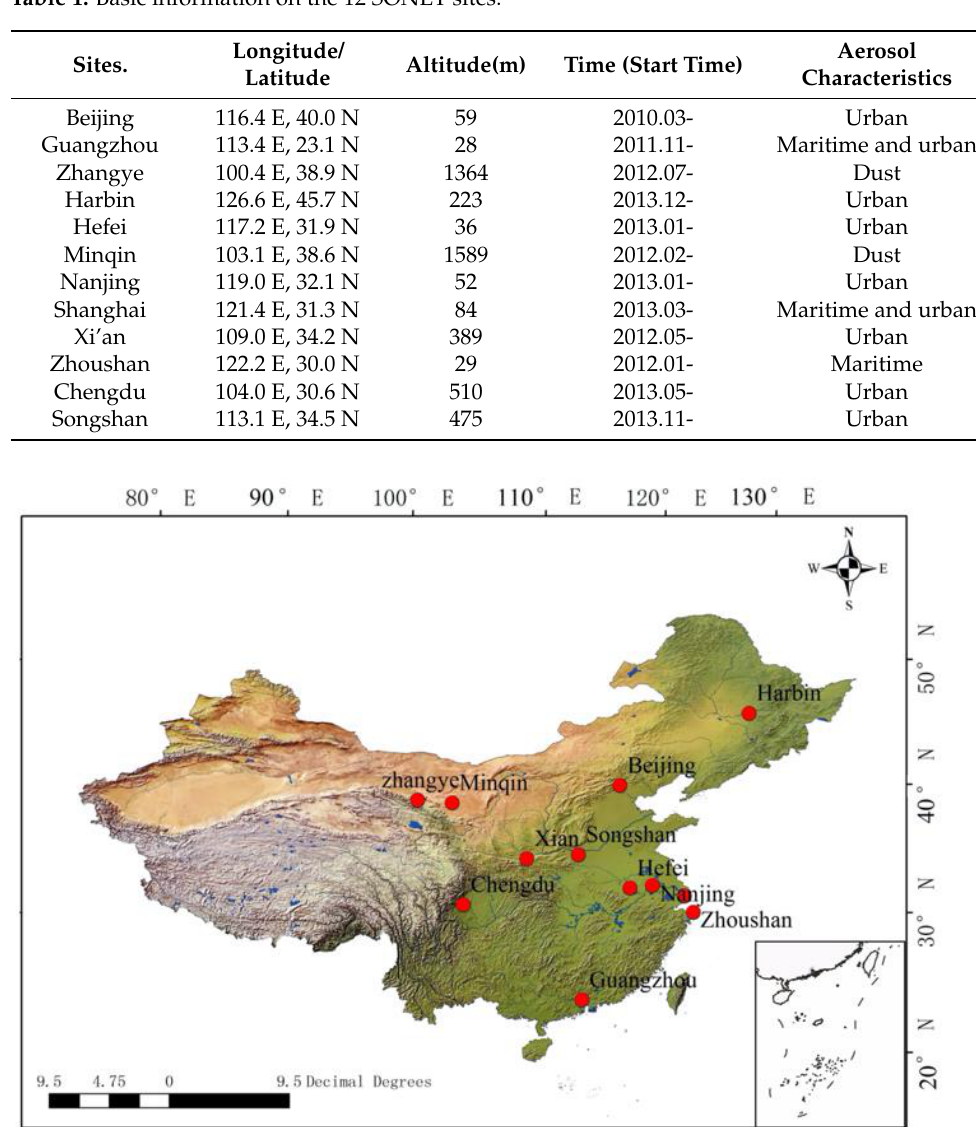
Figure 1. Map of 12 SONET sites in China.